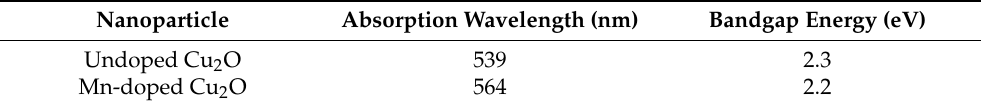
Figure 3. ( a ) Absorption spectra ( b ) ( α h ν ) 2 vs (h ν ) plots of the nanoparticles. Table 2. Absorption edge and band gap energy of undoped and Mn-doped Cu 2 O nanoparticles. Nanoparticle